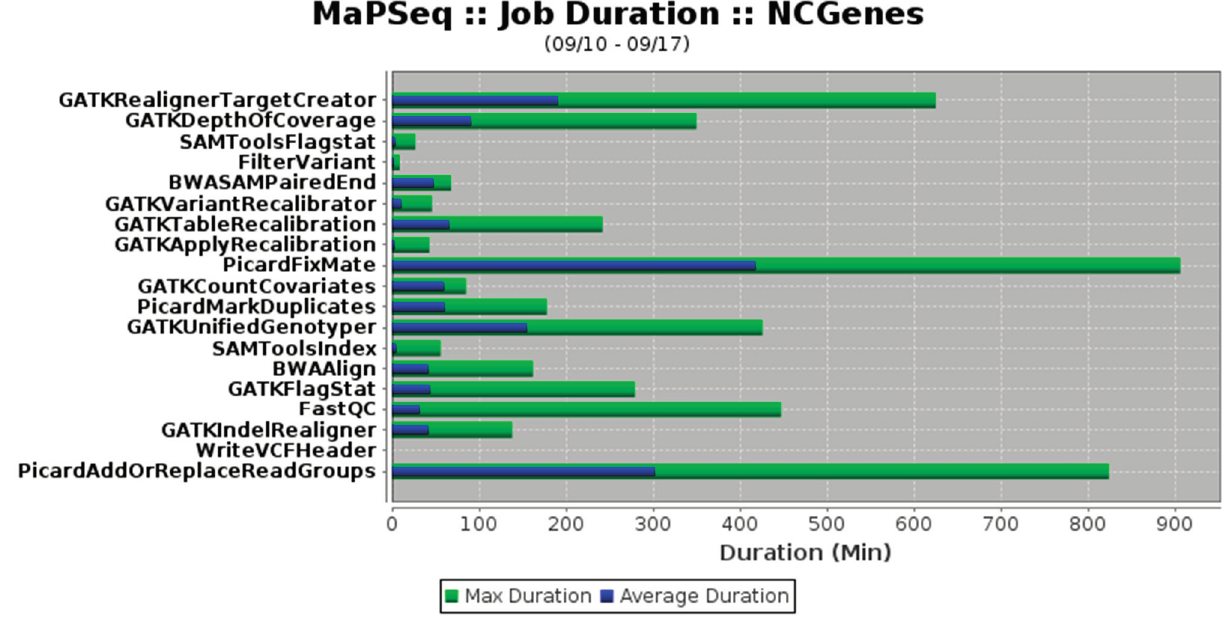
Figure 2. An example of a MaPSeq output log showing the duration of a job (total and average minutes (min) over a one-week time period) by specific